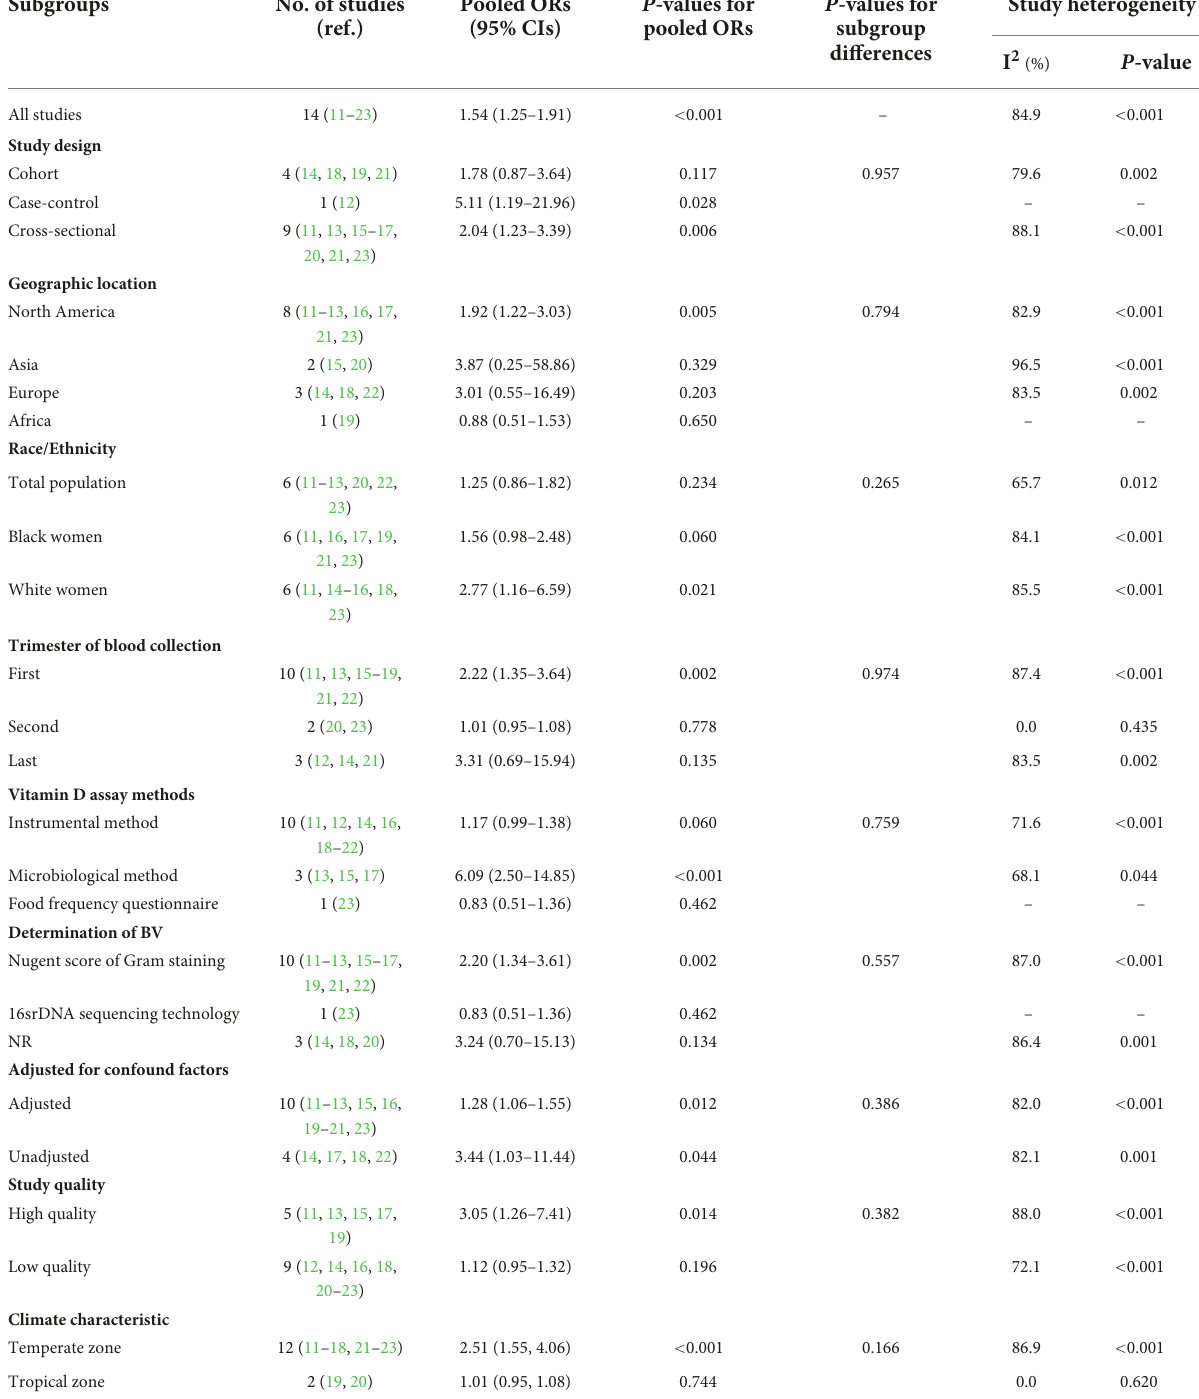
TABLE 2 Pooled ORs of subgroup analyses for the association between Vitamin D deficiency and the risk of bacterial vaginosis (BV). Subgroups No. of studies Pooled ORs (ref.) (95%